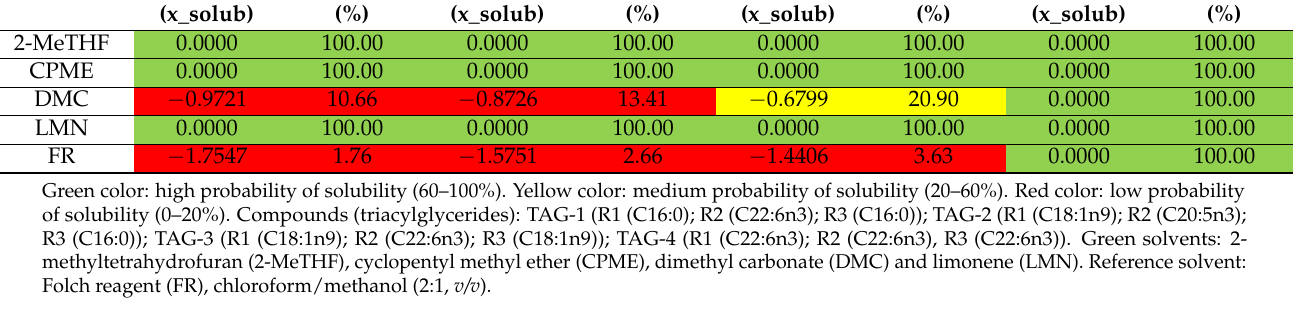
Table 2. Monkfish liver oil extraction with four green solvents and a conventional solvent (reference solvent) using two blending systems (mean ± standard deviations, n = 2).